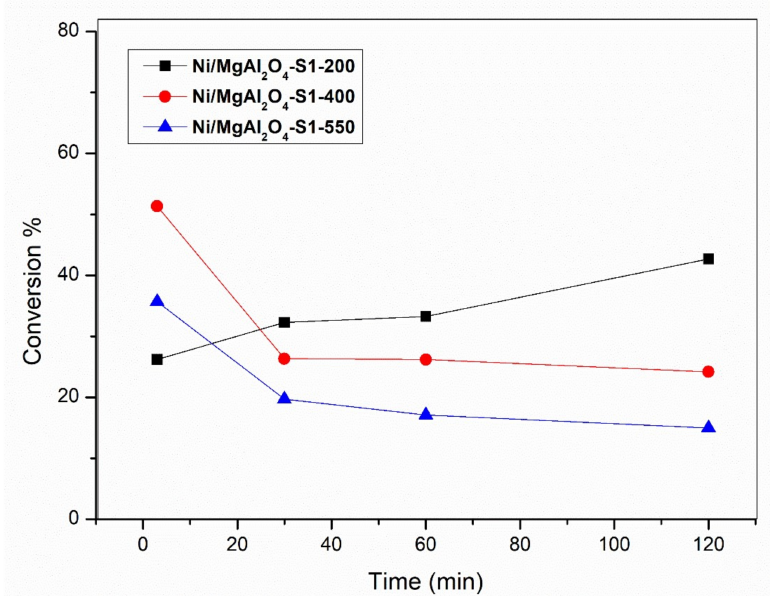
Figure 14. Conversion % of Ni/MgAl 2 O 4 sulfided with (NH 4 ) 2 SO 4 at 200 ◦ C (black square), 400 ◦ C (red circle) and 550 ◦ C (blue triangle).